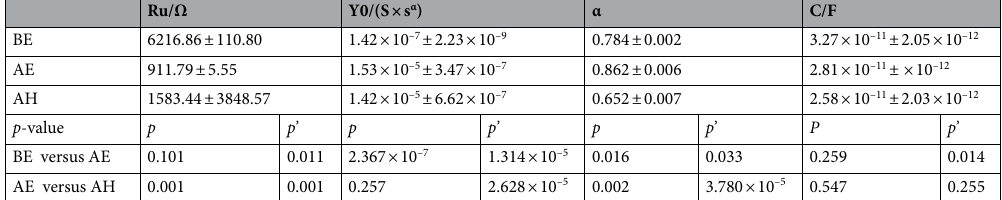
Table 2. List of all the components extracted from the equivalent circuit model shown in Fig. 3 and two-tailed p -value using paired t-test, including the electrolyte resistance (Ru), the admittance (Y0), the exponent (α) of the constant phase element (CPE), and the parasitic capacitance (C). Evaluations are made both with outliers (14 electrodes) and without outliers (8 electrodes). BE before electroplating, AE after electroplating, AH after hydrogel coating. p : p -value of all data, p ’: p -value of data with outliers excluded.